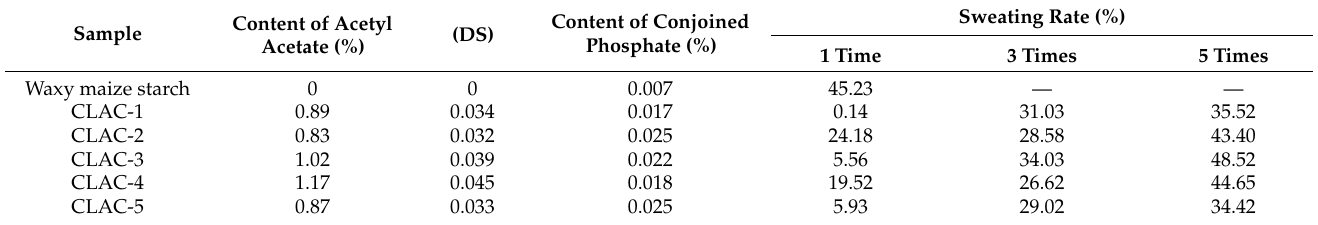
Table 2. Freeze-thaw stability of waxy native corn starch and cross-linked esterified composite modified starch paste.